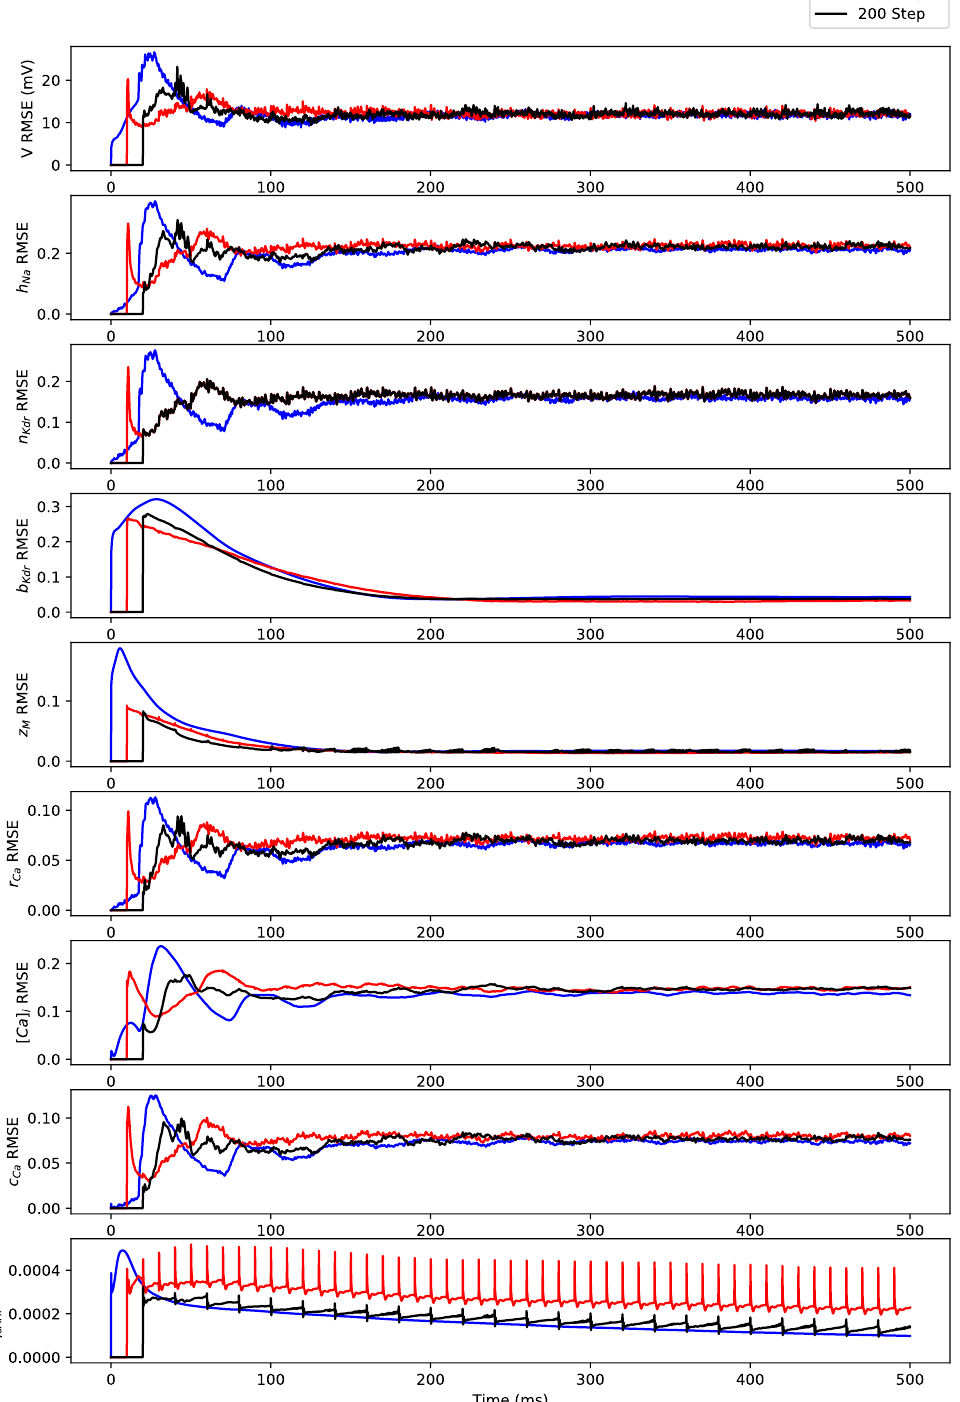
Figure A15. The root mean squared error (RMSE) versus simulation time for 5000 independent realizations, drawn from the predicted membrane potential trajectories of 50 randomly selected stimulating currents from a Uniform distribution U ( 0.24,0.79 ) and 100 random initial conditions for each stimulating